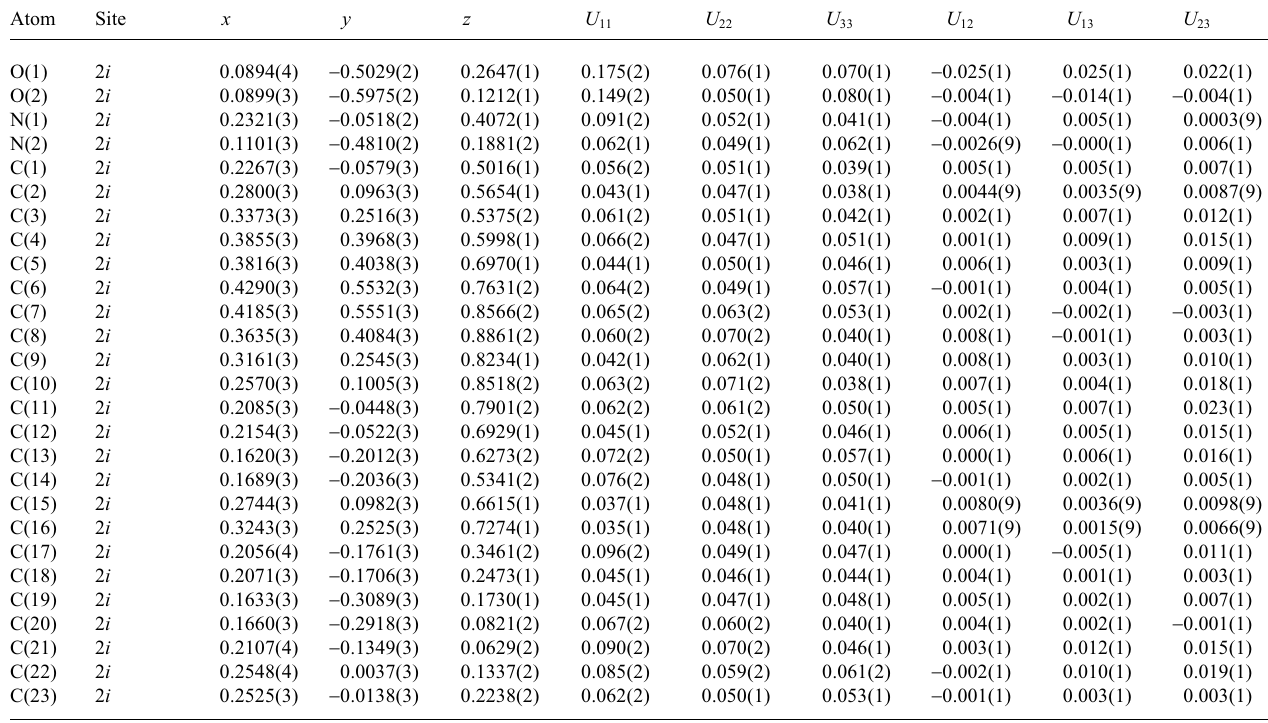
Table 3. Atomic coordinates and displacement parameters (in Å 2 )